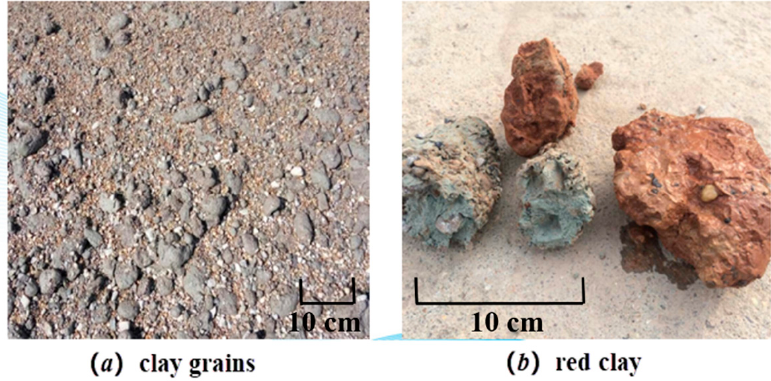
Figure 15. Clay grains and red clay in the excavated soils.